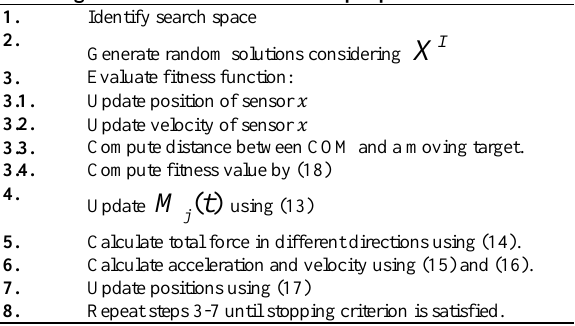
Algorithm 1. Procedure of the proposed method